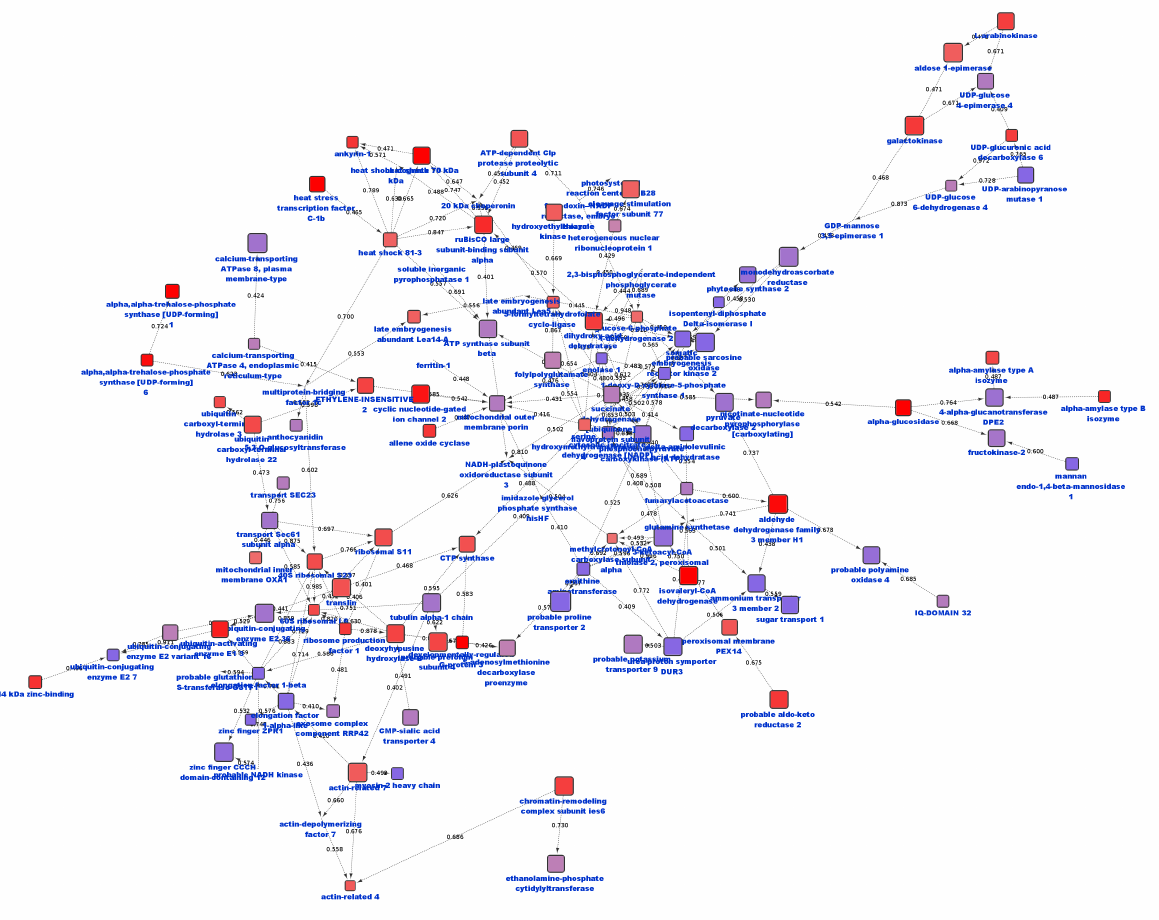
Figure 7. The protein-protein interaction networks of DEGs genes of H.ctrl gene profile. The node size and color stand for gene significance (logpvalue) and gene expression (LogFC)